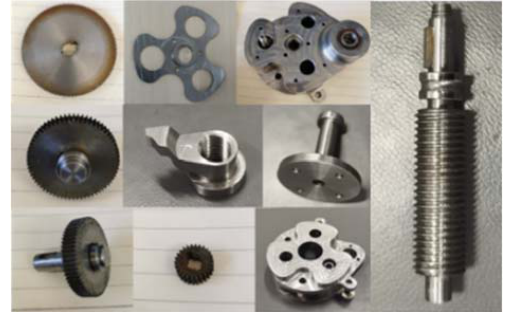
Figure 19. Prototype parts.